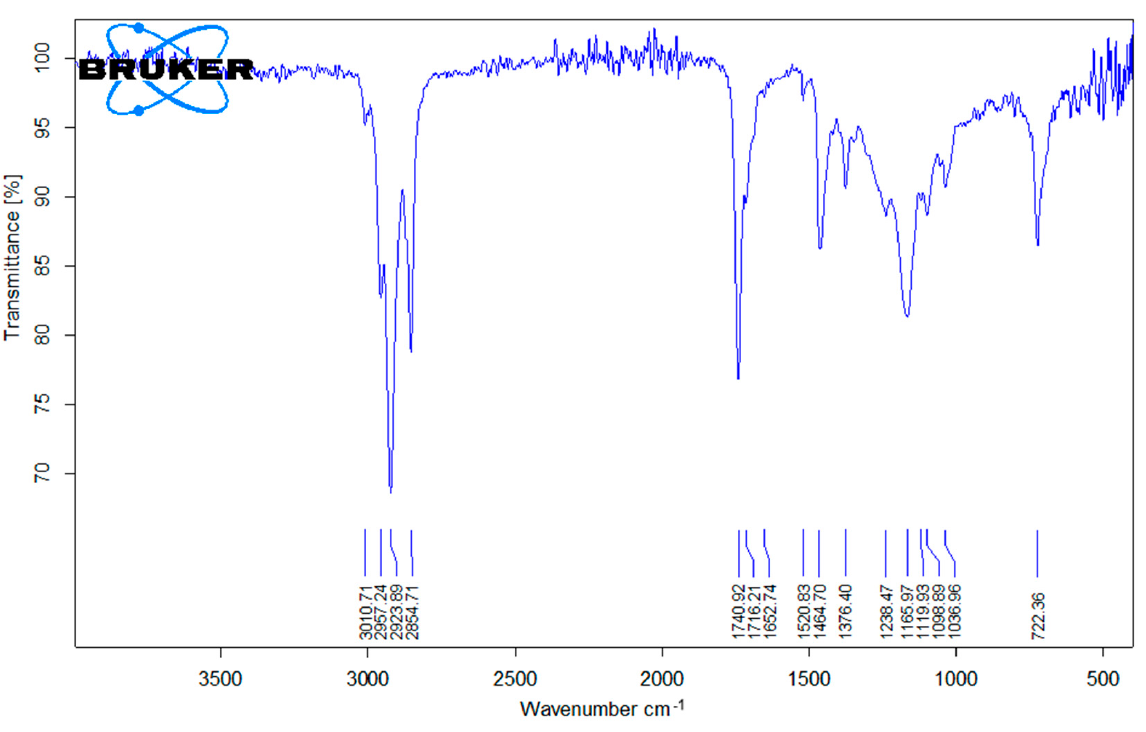
Figure 1. Representative FTIR spectra of lipids extracted from wholegrain stone milled, recombined roller milled, reference flour and commercial wholegrain soft wheat